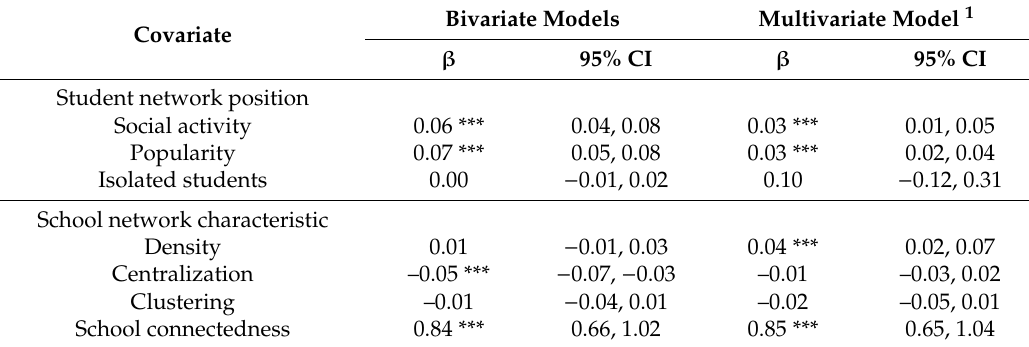
Table 3. Standardized betas ( β ) and 95% CI for schoolwork engagement from the multilevel linear regression models on students’ network position and school network